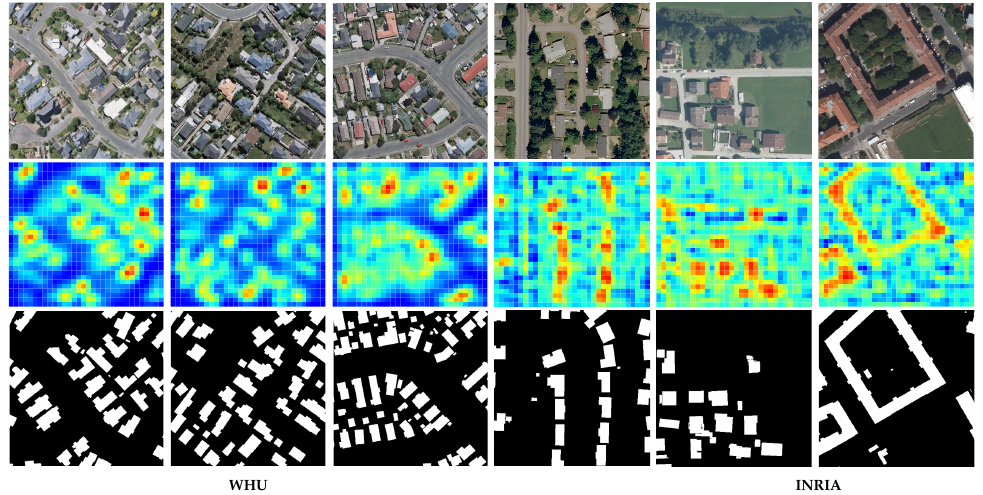
Figure 5. Visualization of the spatial probabilistic maps. The rows from top to bottom are the input image, the spatial probabilistic map, and the ground truth label, respectively. High values are shown in red color and lower values are shown in blue. The heatmaps are taken from spatial map generator with pixel resolution of 32 ×